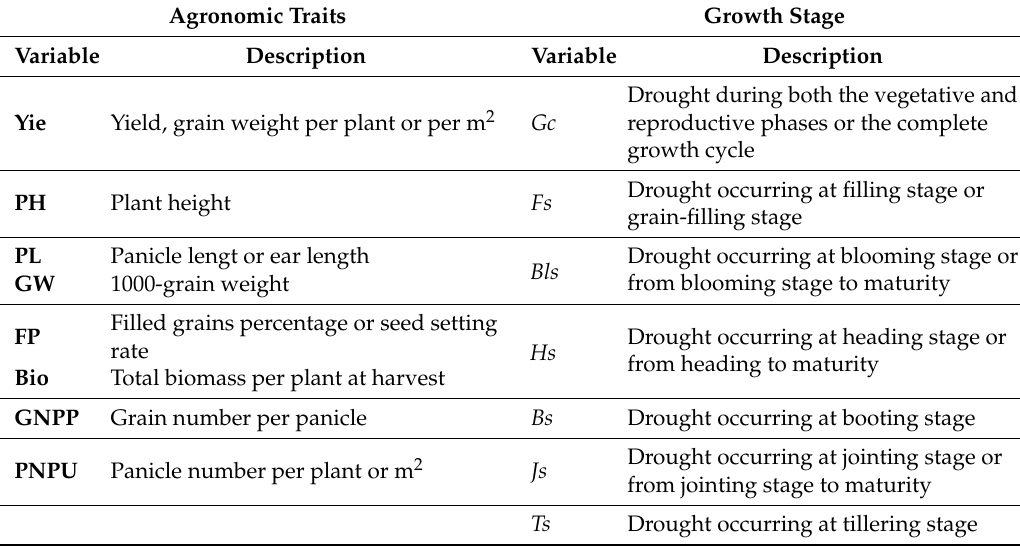
Table 2. List and description of response variables reported in the meta-analysis